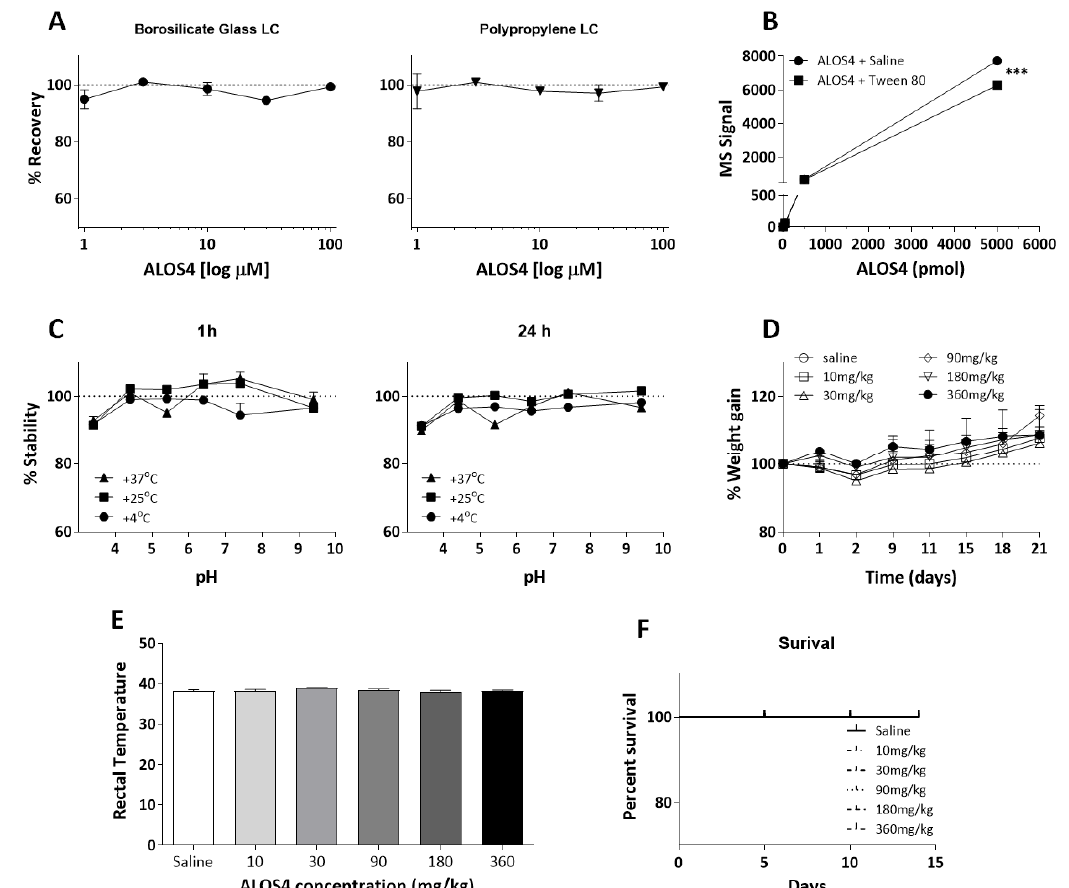
Figure 4. ALOS4 inert materials adherence, pH stability, temperature stability, safety, and toxicity. ( A – C ) LC-MS analysis of ALOS4 recoverability following inert materials exposure and storage under different pH, temperature, and formulation time conditions. ( A ) ALOS4 does not adhere to borosilicate LC glass vials or polypropylene LC vials at concentrations up to 100 µM. Data repre- sent mean ± SEM ( n = 3). ( B ) ALOS4 showed optimal stability in standard saline solution (0.9% NaCl) in comparison with saline containing 0.1% Tween-80 at concentrations of 0.5, 5, 50, 500, or 5000 pmol/µL ALOS4 incubated for 60 min at 25 °C in standard polypropylene tubes. Data repre-